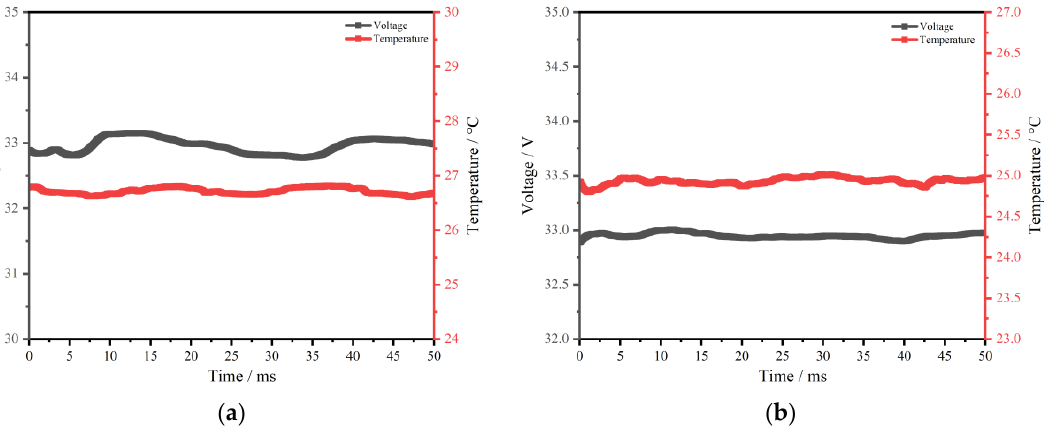
Figure 13. Voltage-temperature-time curve of the battery at Z − positions. ( a ) Test results at Z3 − position; ( b ) Test results at Z4 − position.